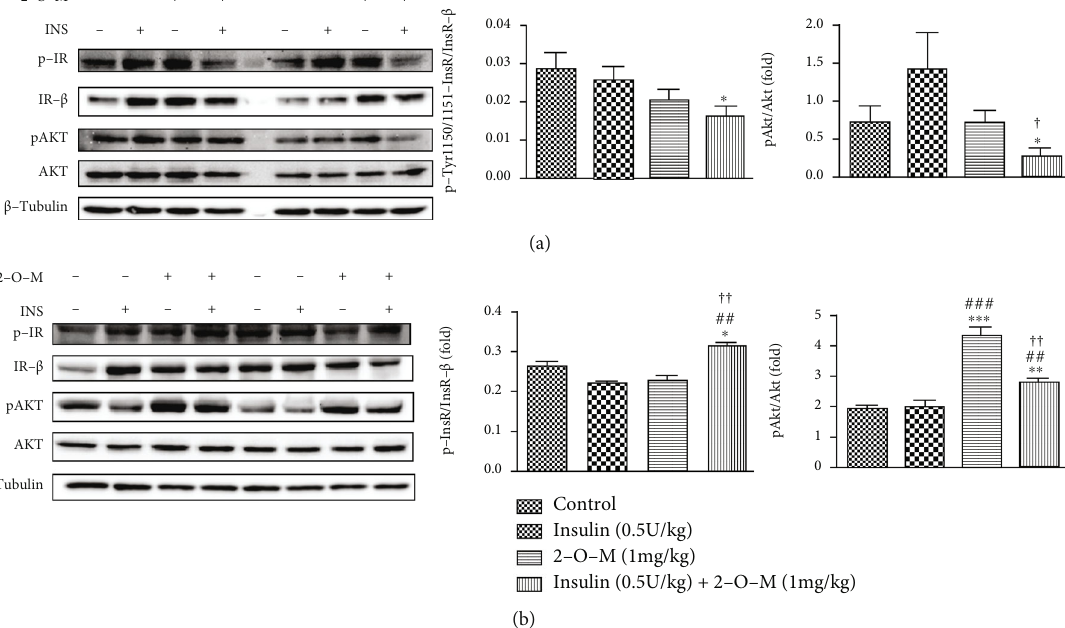
Figure 4: 2 ′ -O-Methylperlatolic acid (2-O-M) enhanced the insulin-activated hypoglycemic e ff ect in db/db mice. (a) Blood glucose change within 120 minutes in db/db mice. (b) Serum insulin level at 120 minutes. Serum C-peptide level at 120 minutes. Serum glucagon level at 120 minutes. Expression of key proteins of the insulin signaling pathway in muscle. Data are shown as the mean ± SEM ( n = 6 in each group). ∗ p < 0 : 05 ; ∗∗ p < 0 : 01 ; ∗∗∗ p < 0 : 001 versus control. # p < 0 : 05 versus insulin. † p < 0 : 05 , 2-O-M versus